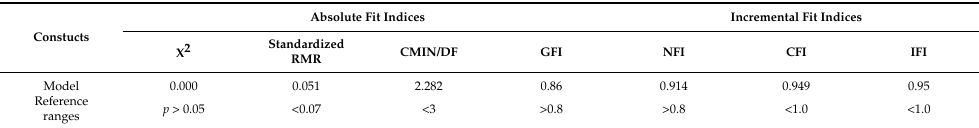
Table 3. Fitness of the structural equation model.